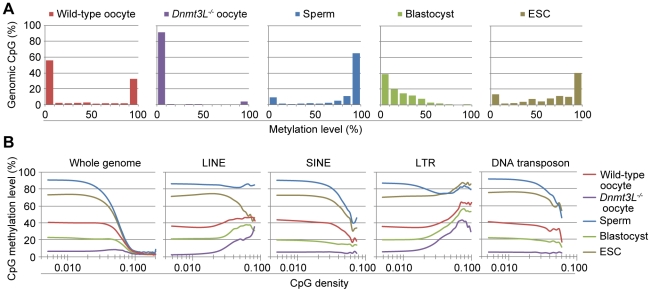
Genome-wide methylation profiling of mouse germ cells.(A) Histograms of methylation levels of genomic CpGs in wild-type oocyte, Dnmt3L−/− oocyte, sperm, blastocyst, and embryonic stem cell (ESC) genomes. (B) CpG methylation levels are plotted as a function of CpG density for the whole genome and 4 families of transposable elements (long interspersed nuclear element (LINE), short interspersed nuclear element (SINE), long terminal repeat (LTR), and DNA transposon).